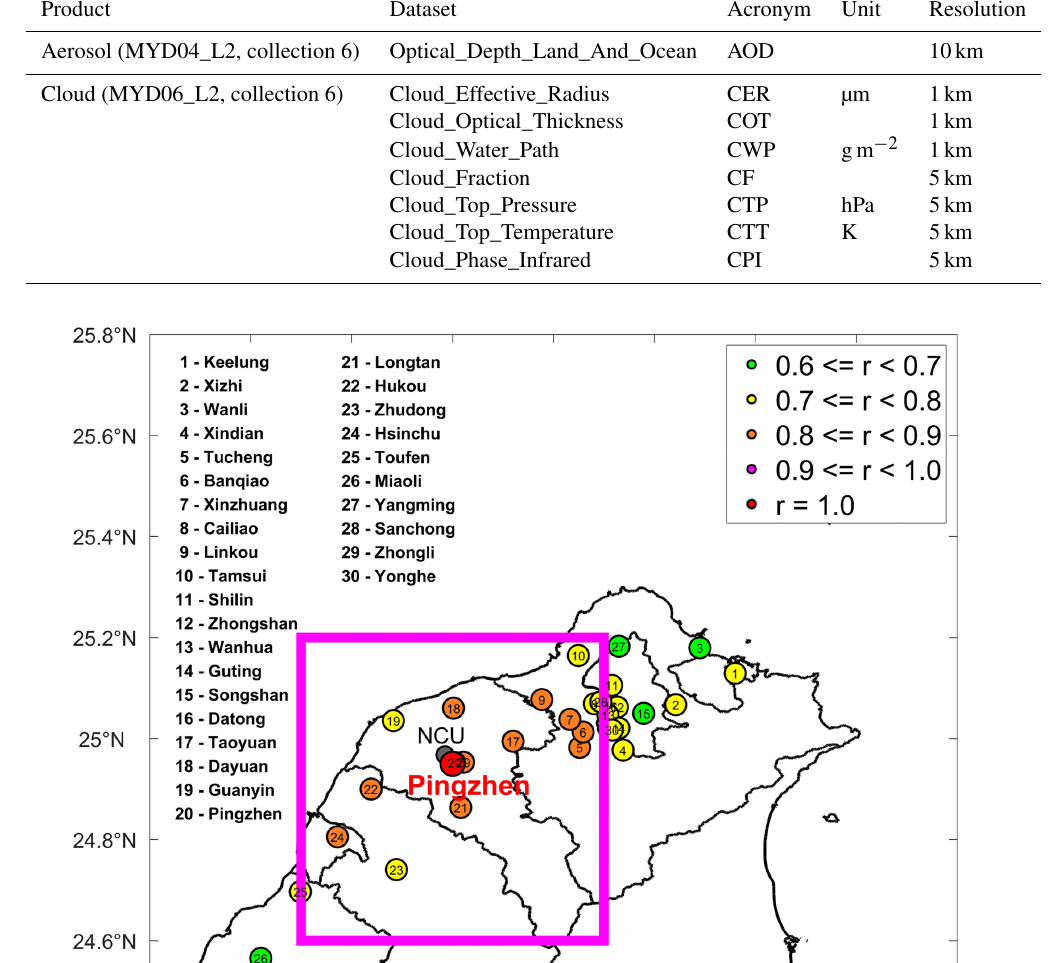
Table 1. MODIS aerosol and cloud products used in this study.